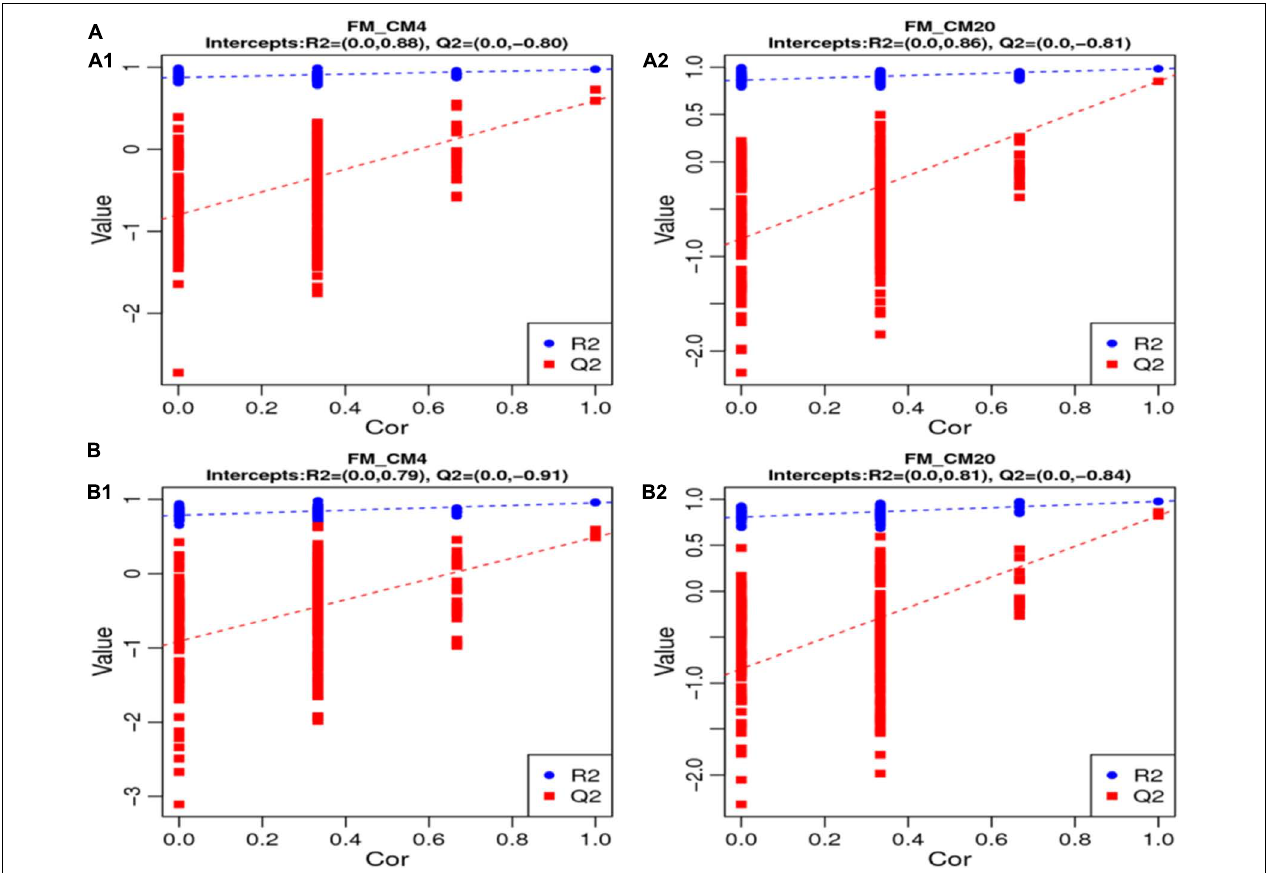
FIGURE 6 | The results of the permutation test of the PLS-DA models of the distal intestinal contents between FM, CM4, and CM20 groups in the positive (A1,A2) and negative (B1,B2) modes. The R2Y value represents the model’s goodness of fit, whereas the Q2 value represents the predictability of the models. Abbreviations are as defined in Figure 1 . n =